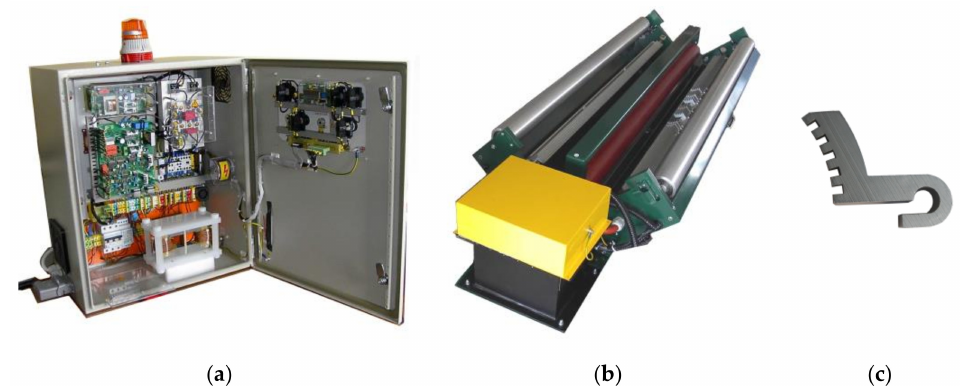
Figure 9. Construction of the devices for processing plastic film using DBD discharges: ( a ) power electronics generator with additional choke; ( b ) HV transformer and electrodes assembly, reproduced from web page IMPiB [45]; ( c ) part of the